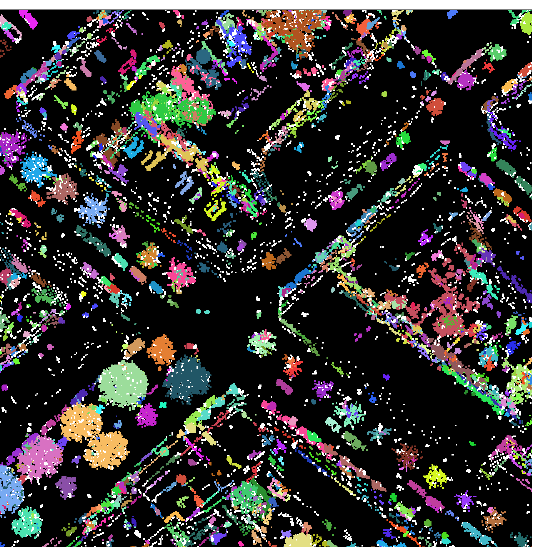
Figure 3. Segment growing based on normal vectors scaled by